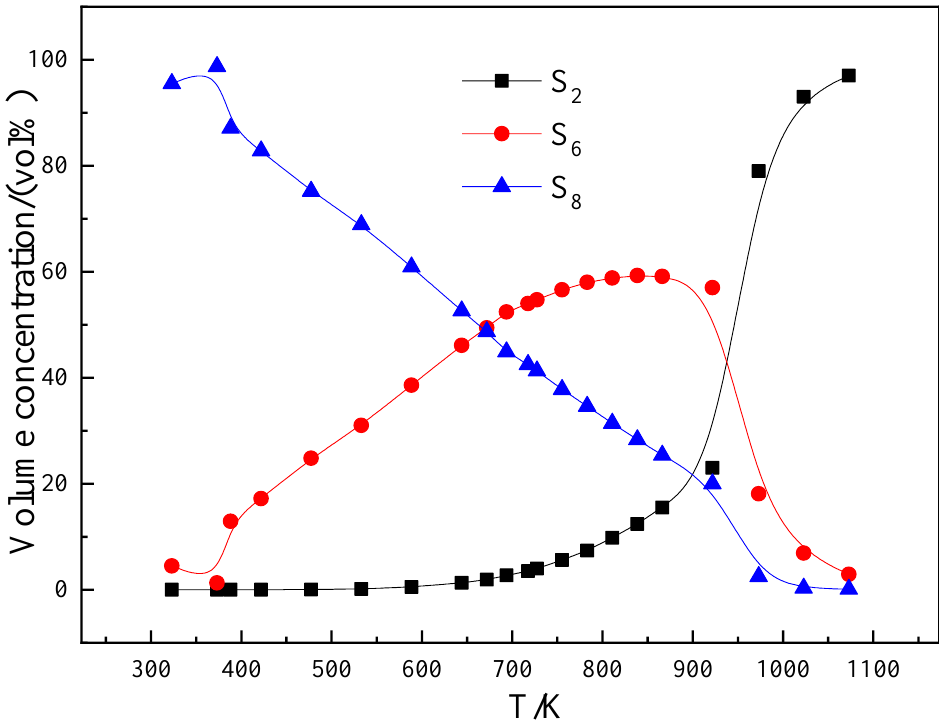
Figure 5. Volume fraction of each component in gas sulfur.